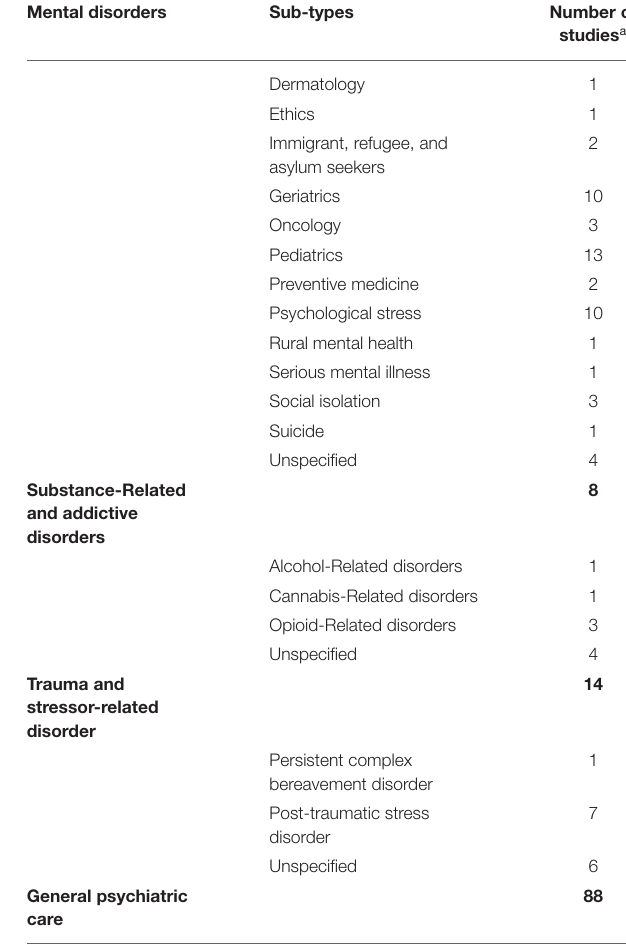
TABLE 2 | Telemental health usage classified by DSM-5 criteria (conditions and